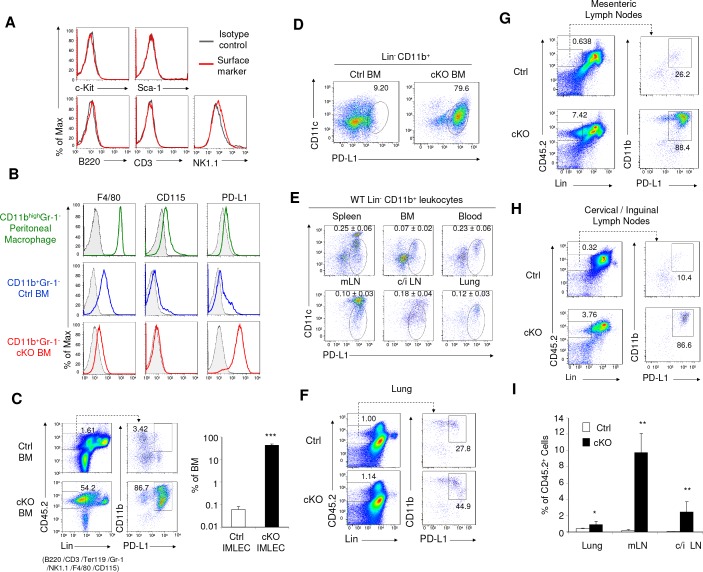
Identification of IMLEC by cell surface markers in both Raptor cKO and WT mice.(A) IMLECs do not express surface markers for conventional lymphocytes (CD3, B220 and NK1.1) and stem and progenitor cells (c-Kit and Sca-1). CD11b+ Gr-1- IMLECs from Raptor cKO BM were tested for their expression of lymphocytes and progenitor cell markers. These data have been repeated three times. (B) IMLECs do not express markers for monocytes and macrophages but surprisingly express high levels of PD-L1. Filled gray areas indicate distributions of fluorescence from stainings by control antibodies. One representative result of at least five experiments is shown. (C) Rptor deletion causes expansion of Lin- (B220- CD3- Ter119- NK1.1- Gr-1- F4/80- CD115-) CD11b+ PD-L1+ IMLECs in BM. Representative flow staining profiles for BM IMLECs (left) and their abundance summary data (right) are presented. n = 5 for Ctrl BM; n = 5 for cKO BM. (D) Lin-CD11b+ PD-L1+ BM IMLECs are CD11c-/low. One representative result of two experiments is shown. (E) The Lin- CD11b+ PD-L1+ CD11c-/low IMLECs are found in various lymphoid and non-lymphoid organs from WT mice. mLN, mesenteric lymph nodes; c/i LN, cervical and inguinal lymph nodes. The numbers (Mean ±SD) are summarized abundances of IMLECs among mononuclear cells (MNCs) from 3 WT mice. (F–H) Rptor deletion caused a broad accumulation of IMLECs in lung (F), mesenteric lymph nodes (G) and peripheral (cervical and inguinal) lymph nodes (H). Results shown are representative of three mice in each group. (I) Summary data showing increased IMLECs in the lymphoid and non-lymphoid organs. n = 3 for both groups.